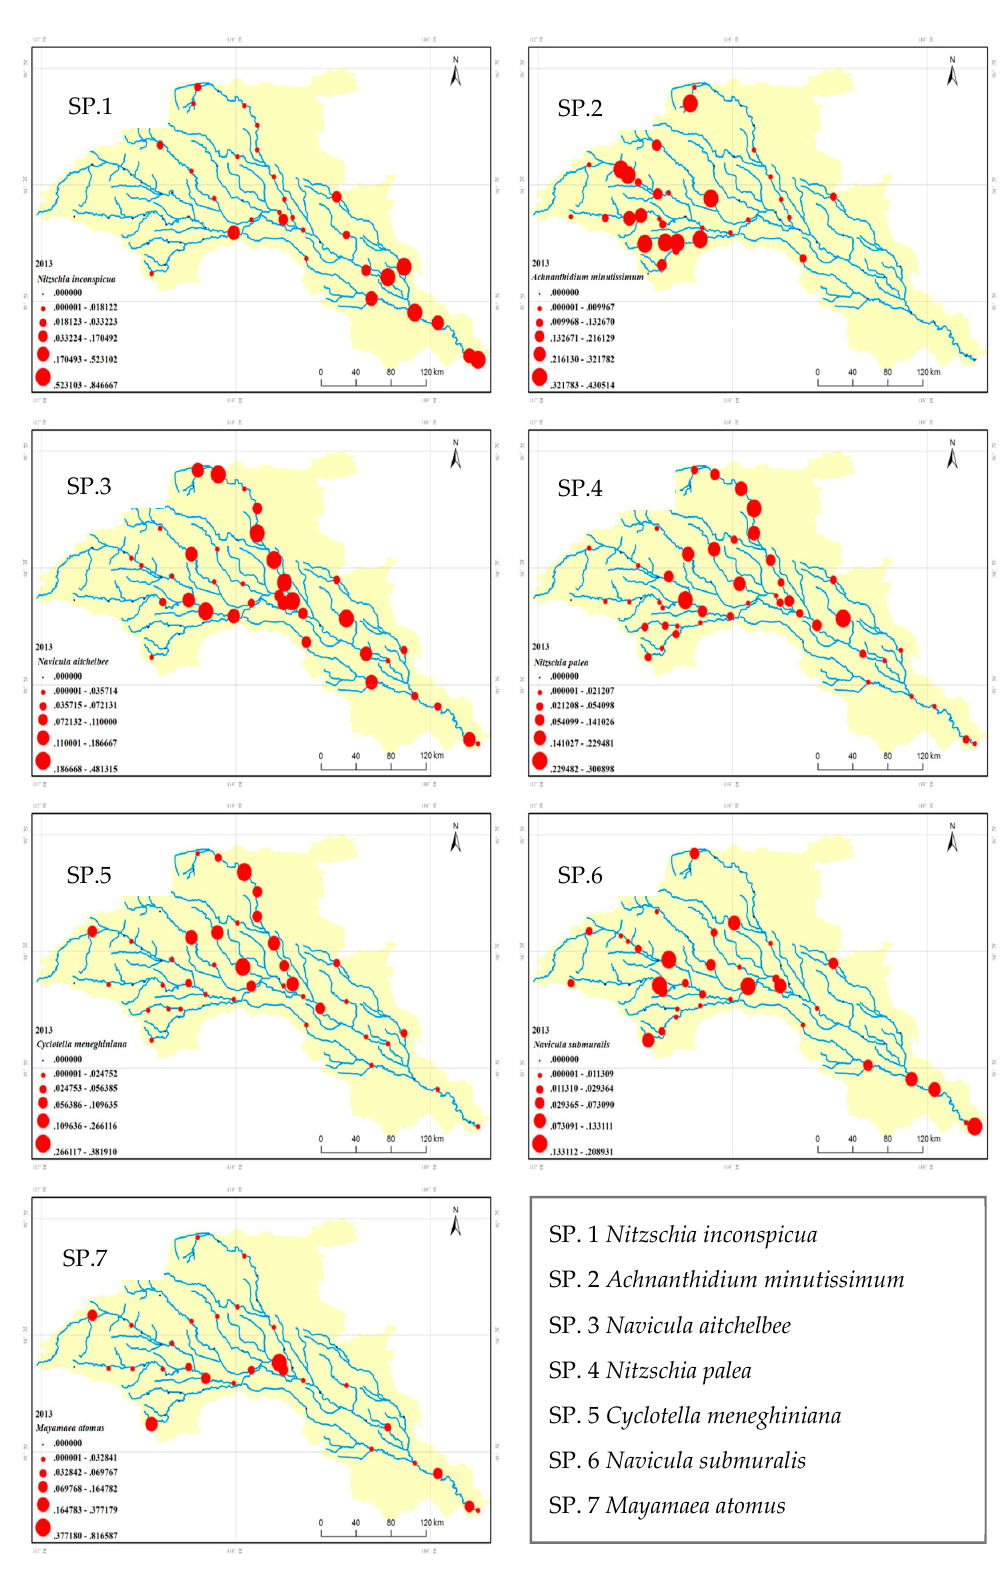
Figure 3. Distribution and dominance Y of benthic diatoms (SP. 1–7) in the Ying River.